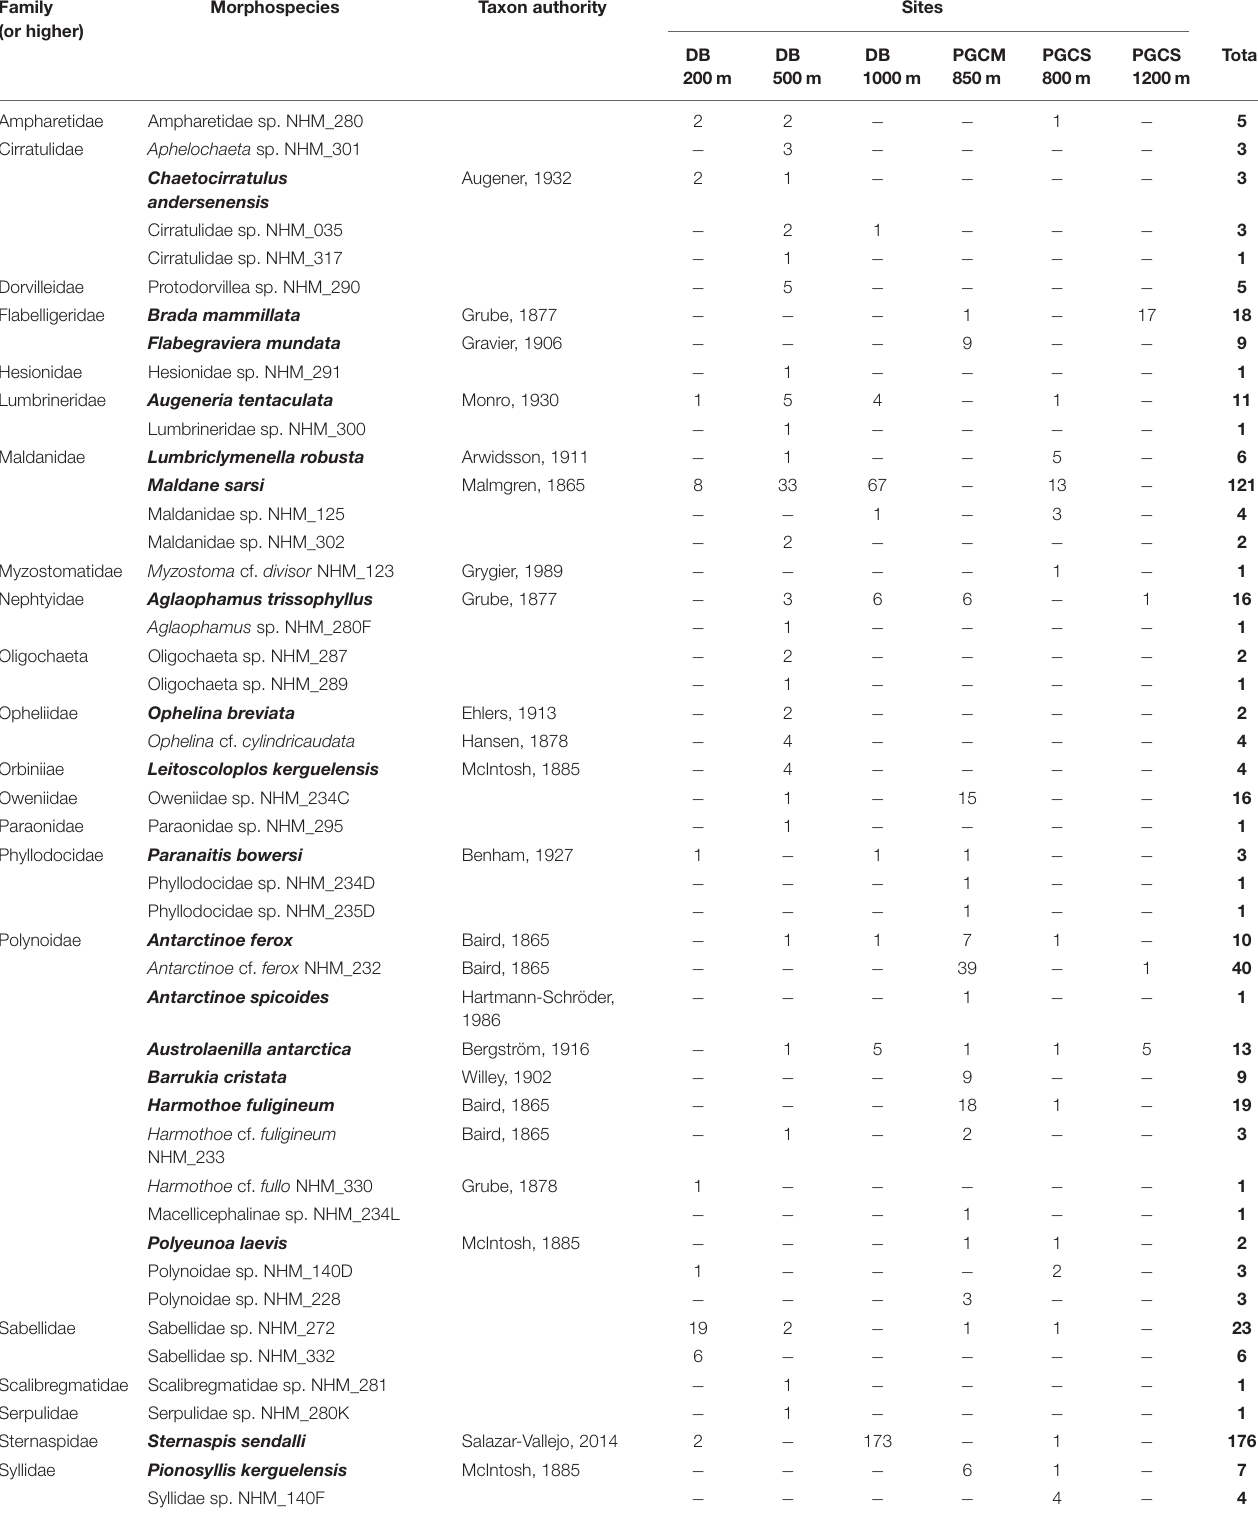
TABLE 3 | List of morphospecies identified from Agassiz Trawl samples collected on cruise JR17003a, with individual counts for each site provided. Family (or higher)